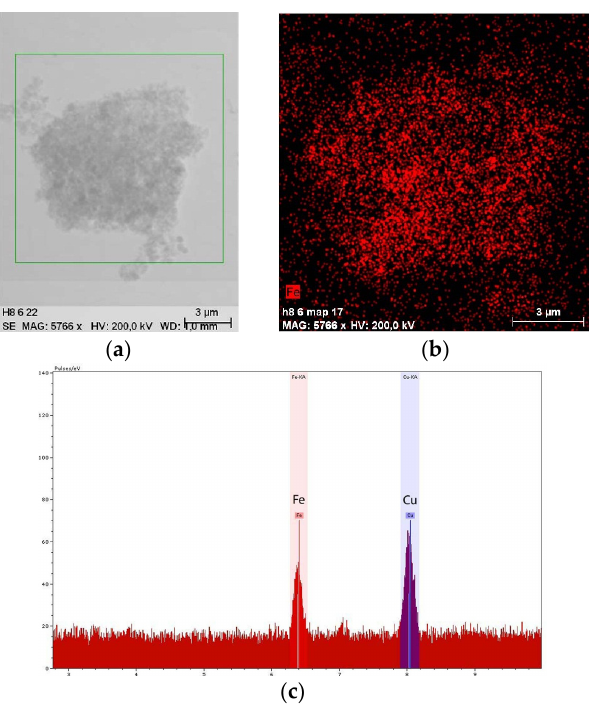
Figure 10. ( a ) TEM image at micro scale; ( b ) chemical mapping in conjunction with TEM image ( a ), red points accumulation represent appearance of iron in particles; ( c ) EDX (energy dispersive X ‐ ray) spectrum, red peak corresponds to Fe and blue peak is Cu from grid of the sample.